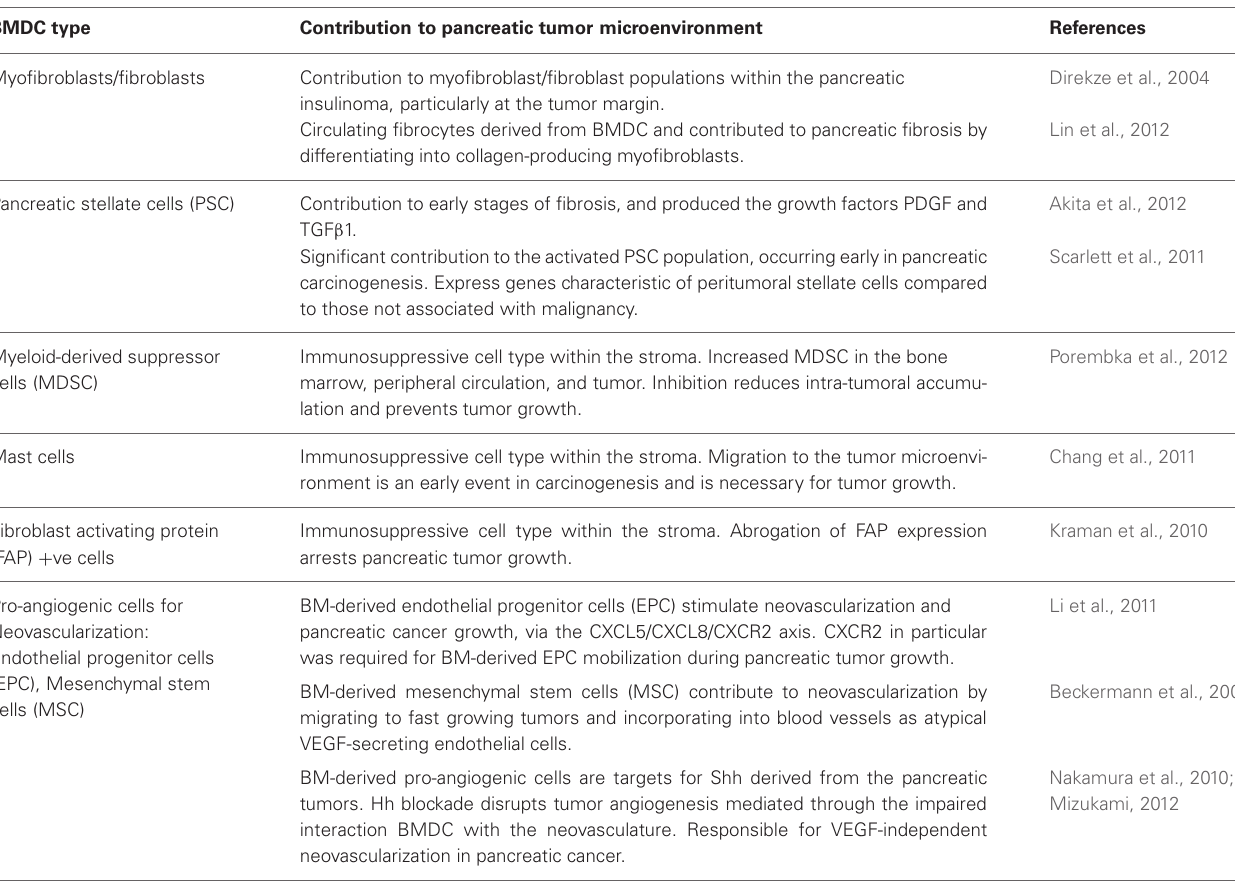
Table 1 | Summary of bone marrow derived cell contribution to the pancreatic tumor